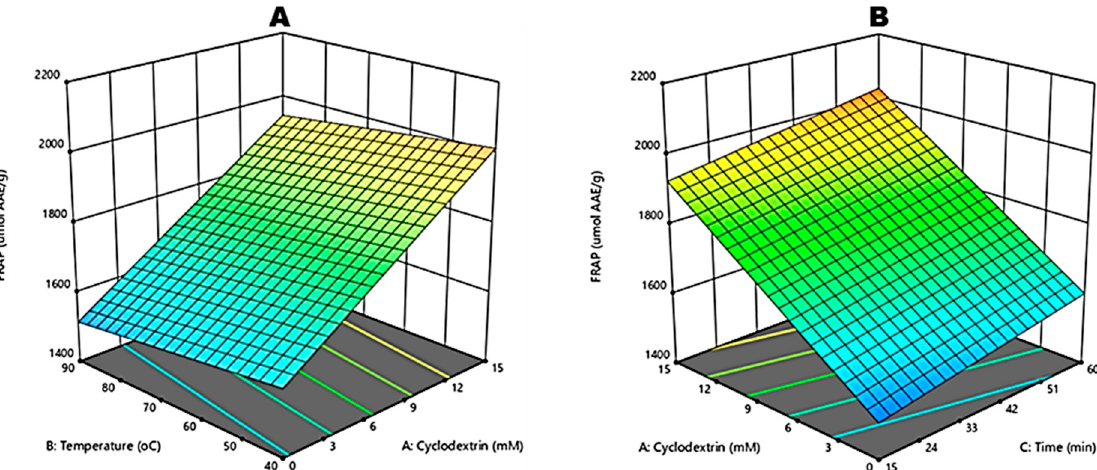
Figure 6. Response surface plots for independent variables for ferric reducing antioxidant power (FRAP) of crude green rooibos extracts: ( A ) effect of Beta-cyclodextrin and reaction temperature and ( B ) effect of Beta-cyclodextrin and reaction time.